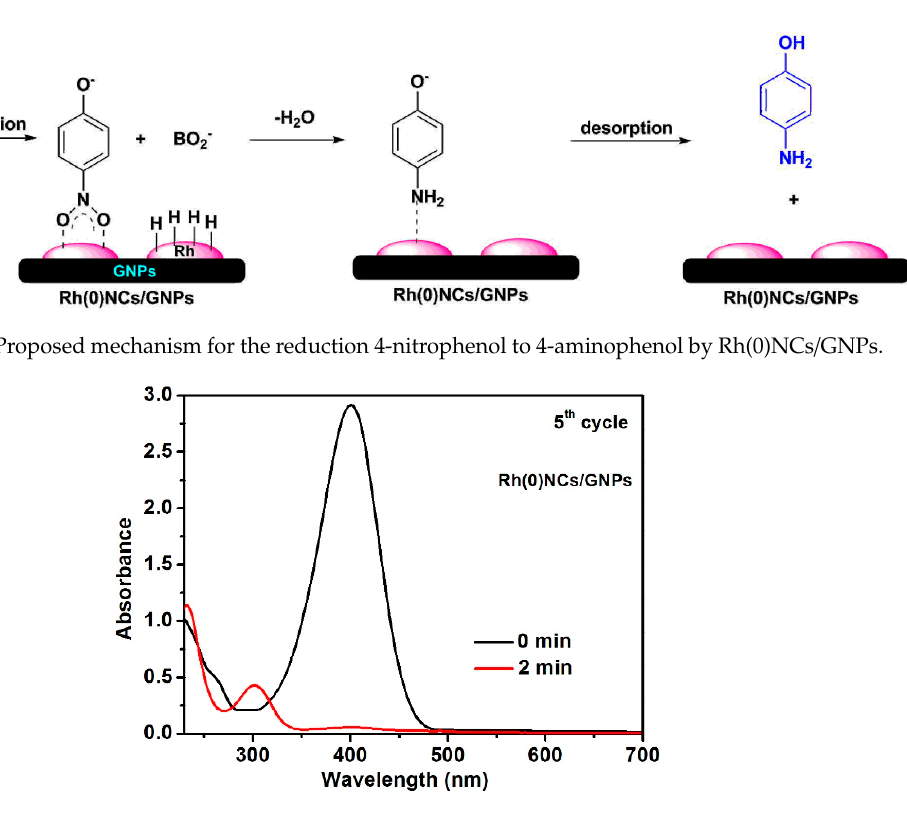
Figure 8. Spectra of the reduction of 4-nitrophenol using 0.002 mg of used Rh(0)NCs/GNPs (5th cycle).